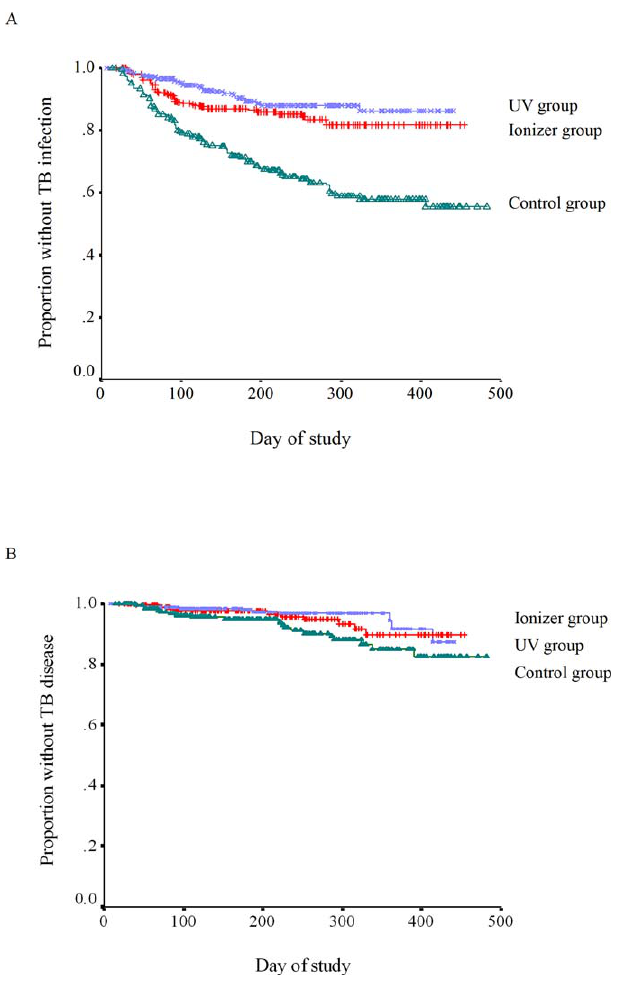
Figure 6. Kaplan-Meier Time-to-Event Curves (A) Using TB infection (PPD skin test conversion) as the end-point. (B) Using TB disease (autopsy or culture evidence of TB) as the